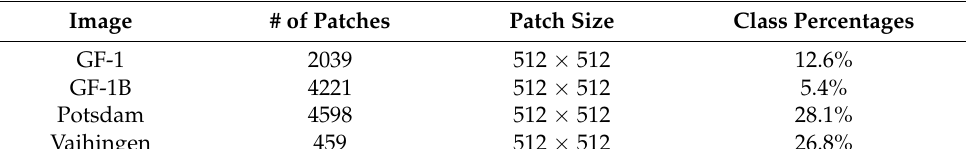
Table 1. Statistics For Data Set.